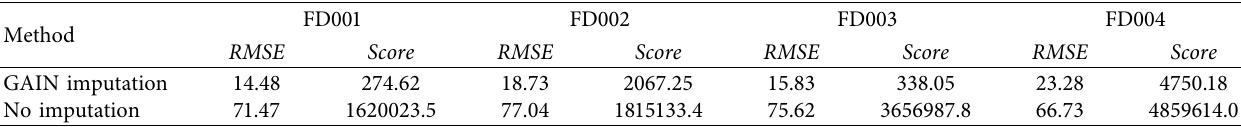
Table 5: The results of the RUL prediction with and without data imputation for a missing data rate of 0.1.